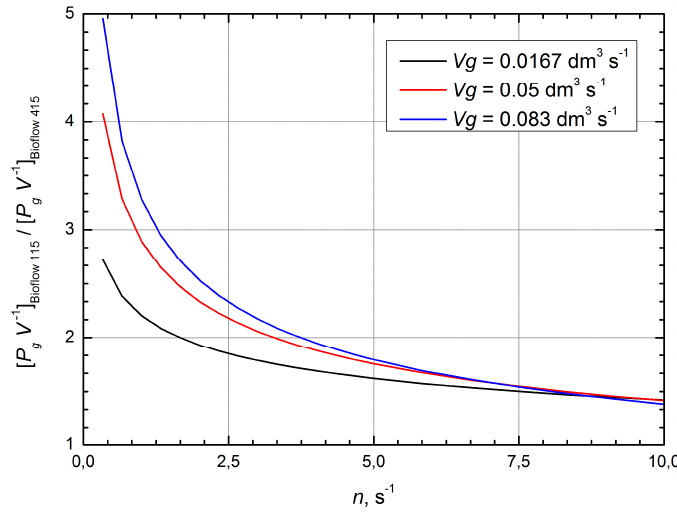
Figure 6. The graphical presentation of the proposed dimensionless ratio as a function of operational parameters (speed rotation and gas flow rate).